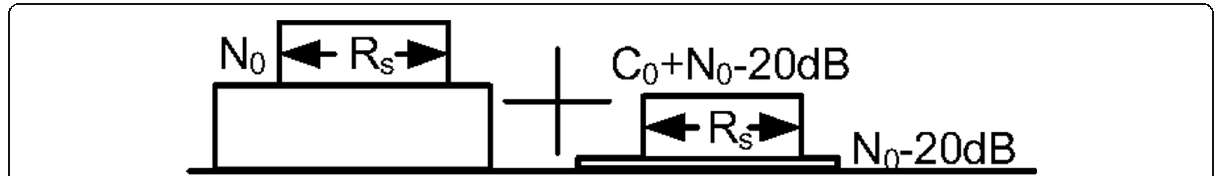
Fig. 2 Equal bandwidth polarization interference schematic diagram. This figure shows an equal bandwidth polarization interference schematic